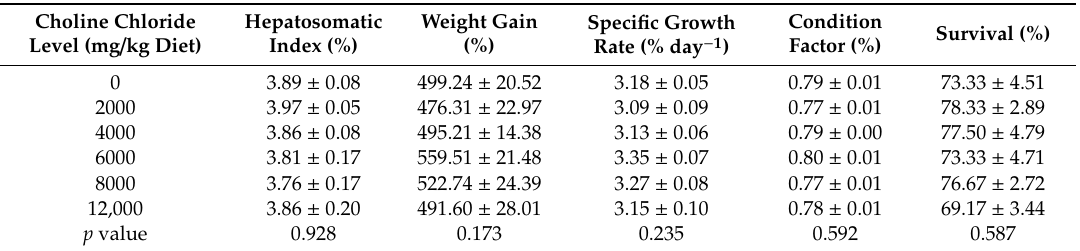
Table 2. E ff ects of di ff erent dietary choline chloride levels on the hepatosomatic index, weight gain, specific growth rate, condition factor, and survival of L. vannamei (n = 4, mean ±